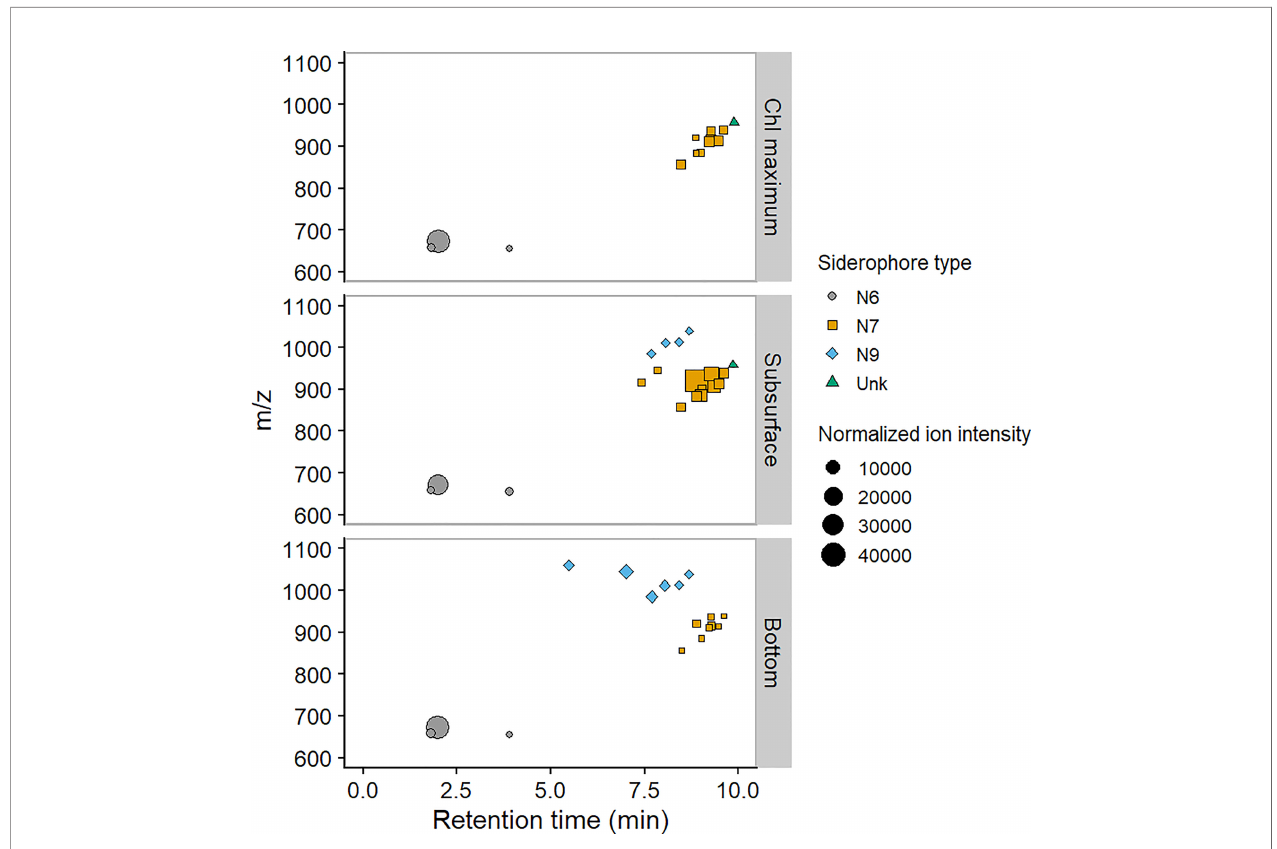
FIGURE 2 | Plot of retention time against mass: charge (m/z) for [M-2H+Fe] + ions of siderophores identi fi ed at station CCS in November 2014. Siderophore family is shown by symbol size and colour: N 6 includes ferrioxamine siderophores, N 7 includes amphibactin siderophores and N 9 includes the marinobactin siderophores whilst Unk indicates siderophores where we were unable to predict molecular formulas (see Table 1 ). The size of the symbol shows ion intensities normalized to preconcentration